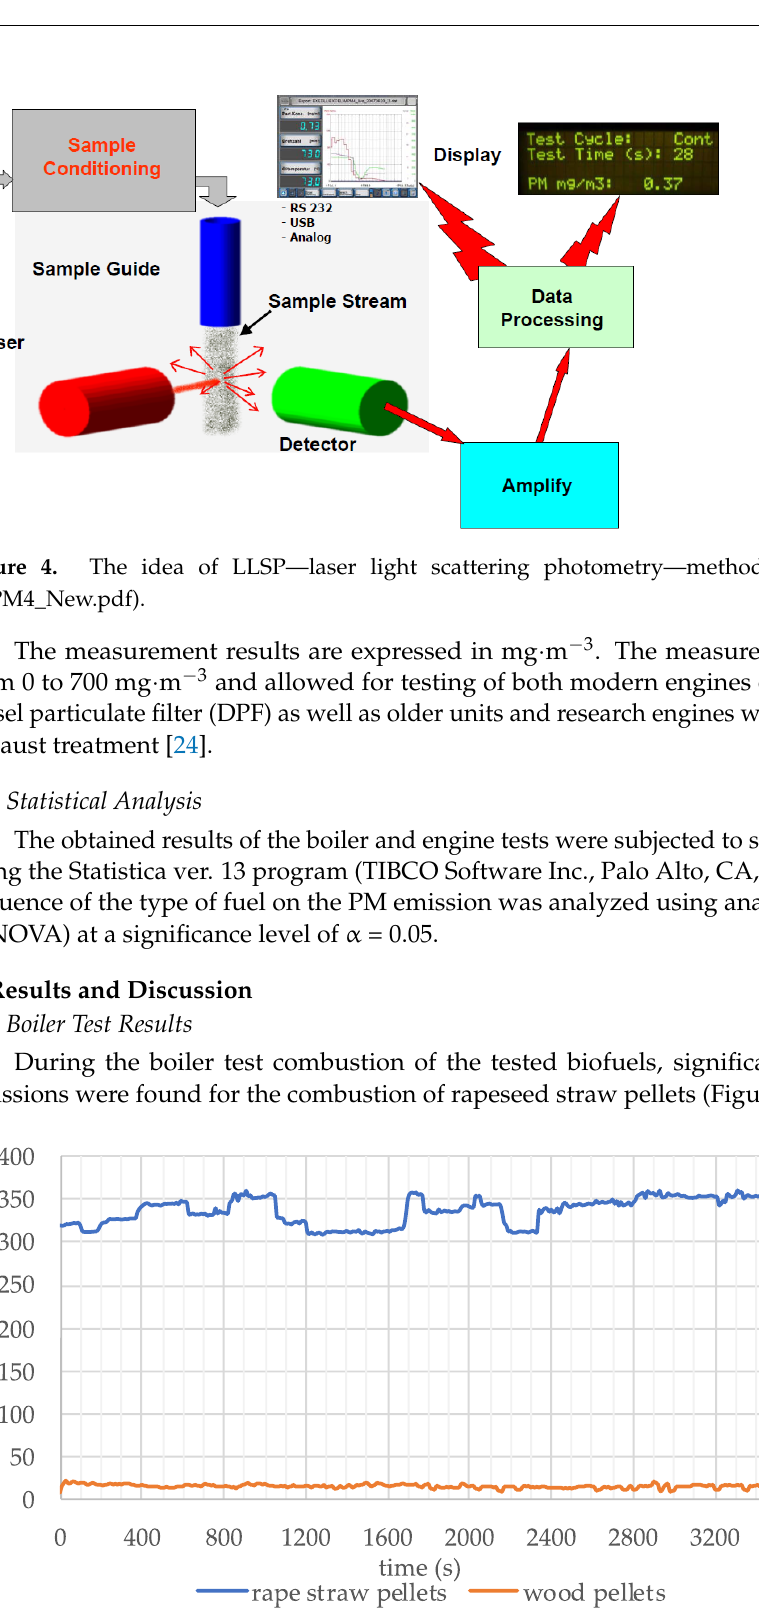
Figure 5. PM emissions during the tests of wood pellets and rapeseed straw pellets.